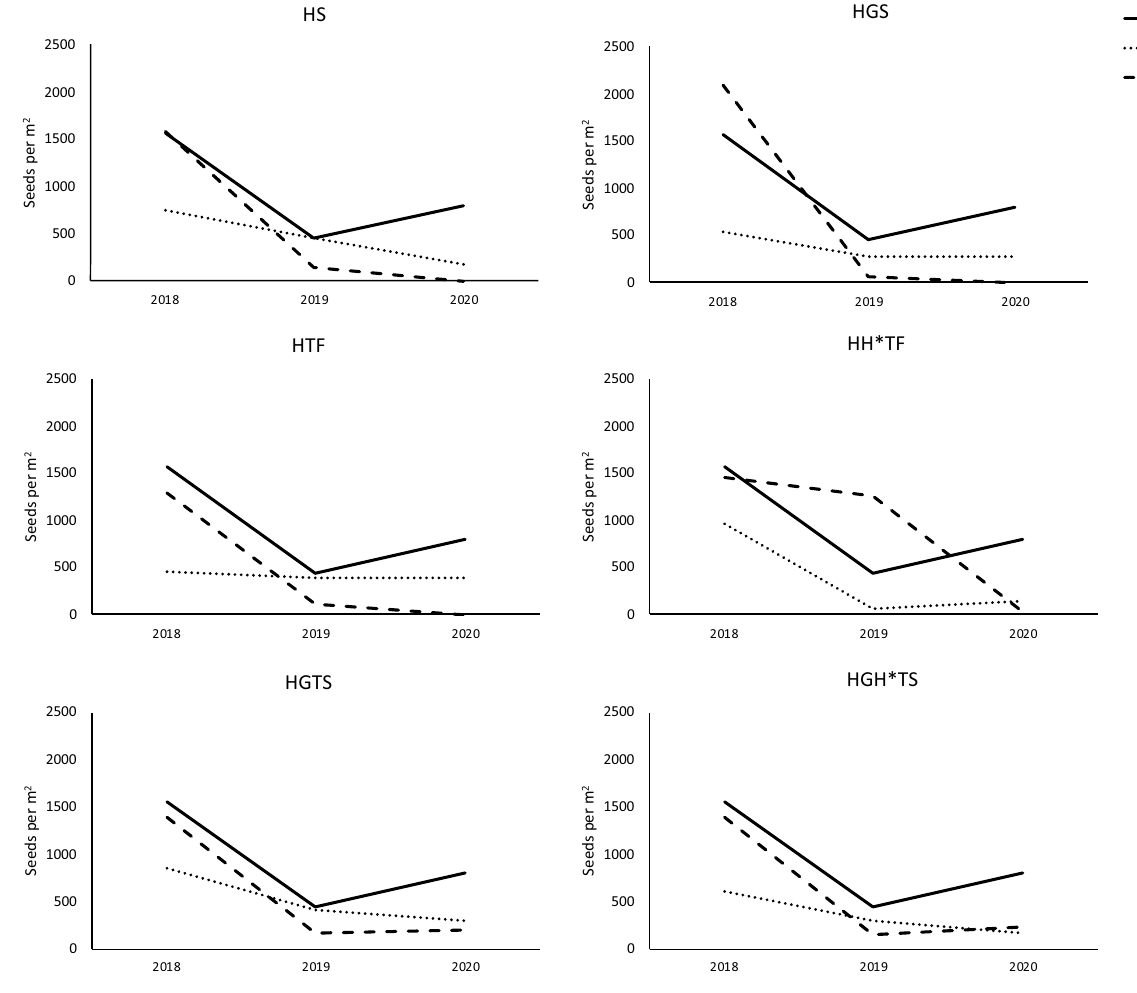
Figure 4. Changes in N. trichotoma ’s seedbank over three sampling periods. Soil was collected pre-treatment in 2018, then post-treatment in 2019 and 2020. Each graph shows the control (no treatment) line for comparison (solid line), the unburnt plots are represented by the dotted line, and the fire treated plots are represented by the dashed